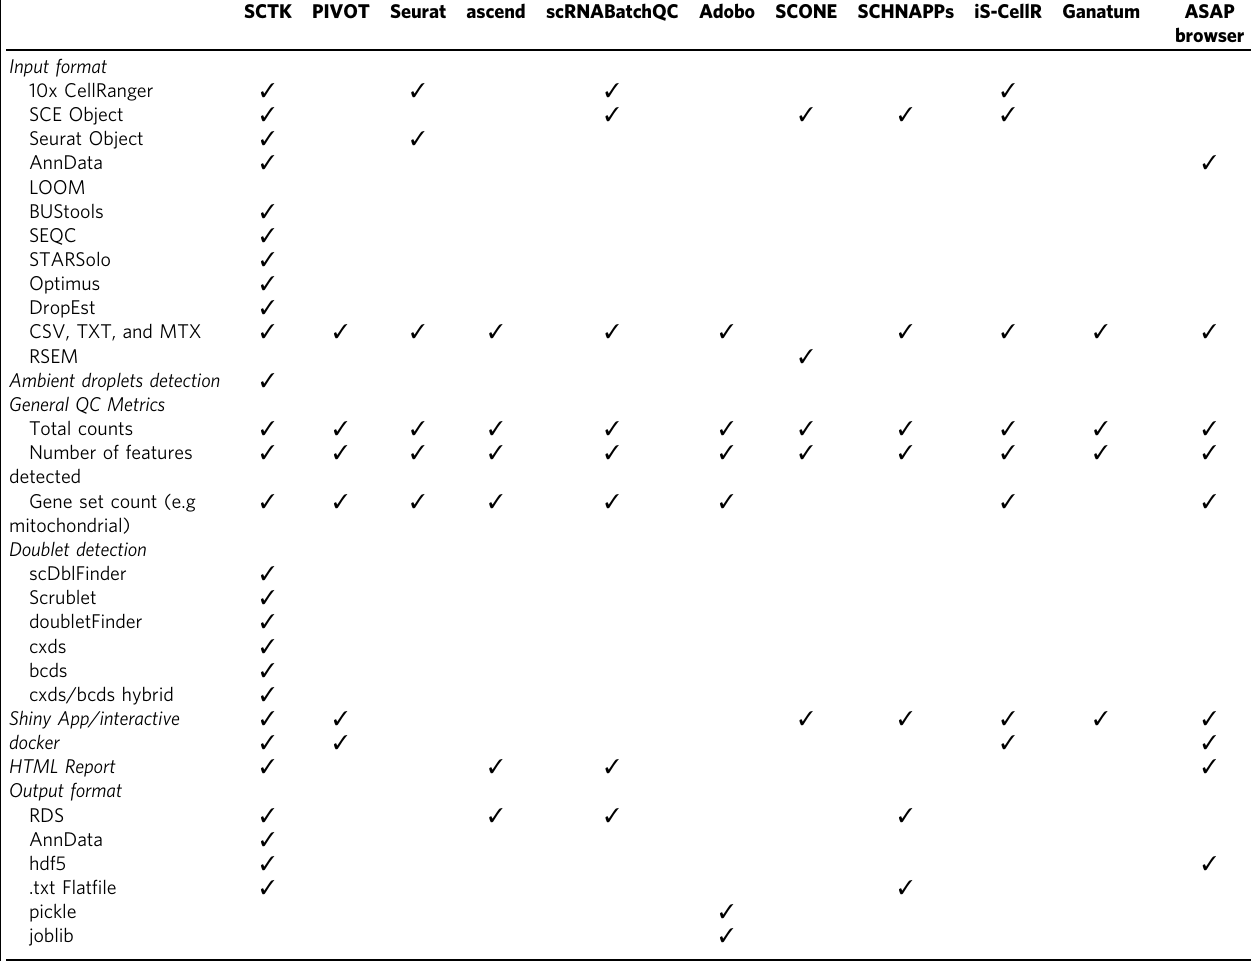
Table 2 Comparison of features in the SCTK-QC pipeline with other single-cell analysis